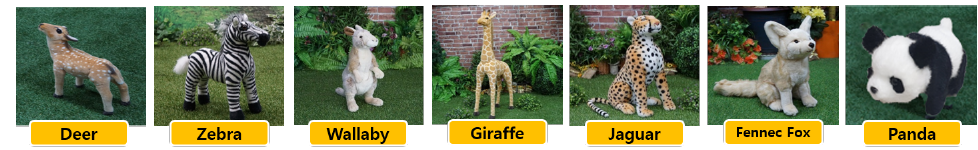
Figure 2. Photo illustration of our dataset with seven animal